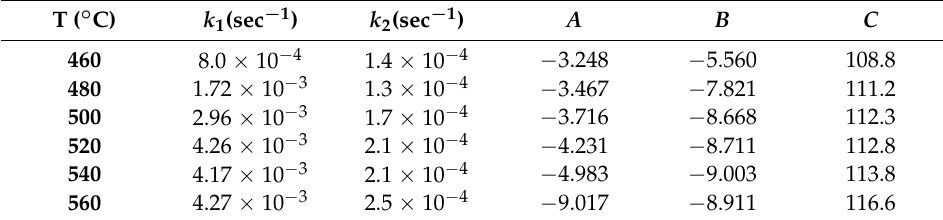
Table 1. Kinetic parameters of reaction between Li 4 SiO 4 and CO 2 for double exponential model [28].